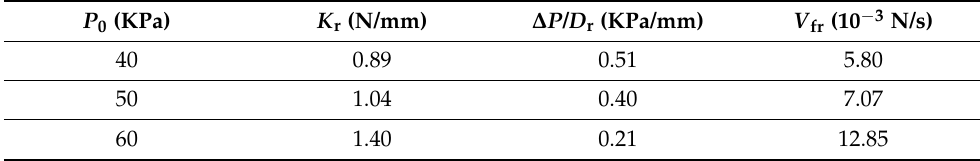
Figure 5. Pneumatic control system. ( a ) Design principle of the actuator. ( b ) Pneumatic deformation process. ( c ) Pneumatic devices. (i) components of the device; (ii) airtightness of the actuator within 600 s. ( d ) Folding angle θ 0 . ( e ) Radial length r . ( f ) Axial length z . ( g ) Radial stiffness K r . When P 0 is equal to 40, 50, and 60 KPa, see ( h ) for actuator stability and ( i ) for the radial creep experiment. Table 2. Radial mechanics of the Waterbomb under pneumatic control.